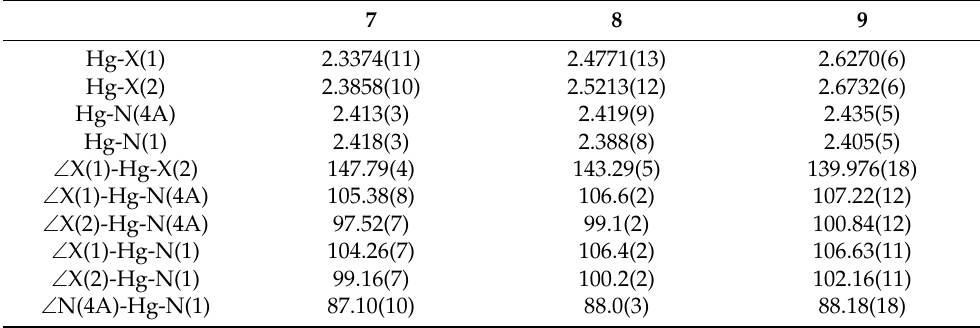
Figure 7. A schematic diagram defining the distances and the dihedral angle.